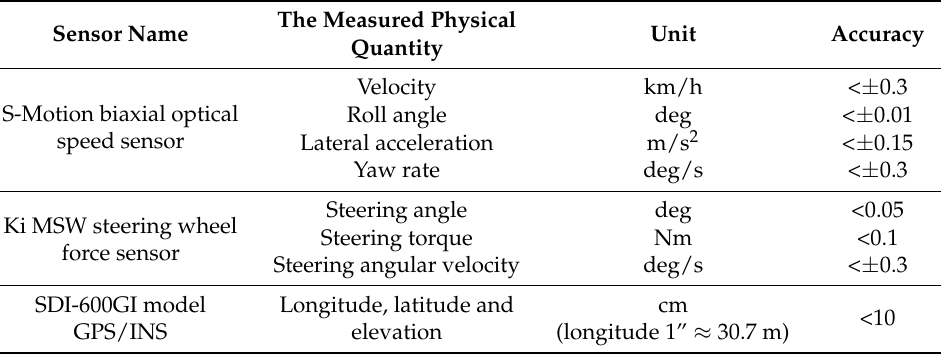
Table 2. Sensor name and